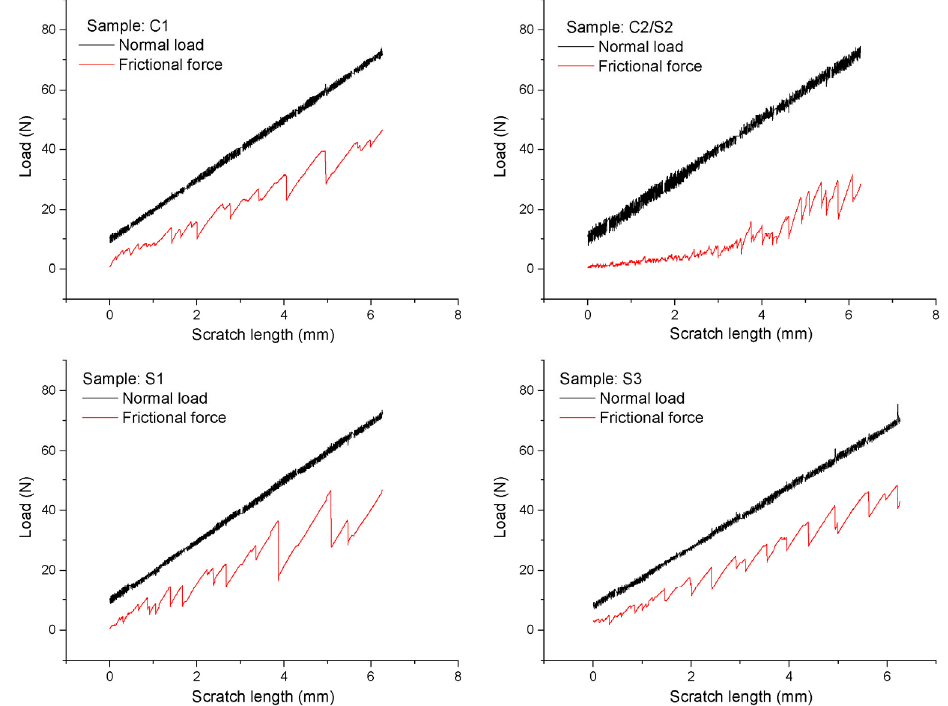
Fig. 8 Load versus displacement curve of coating performance during scratch